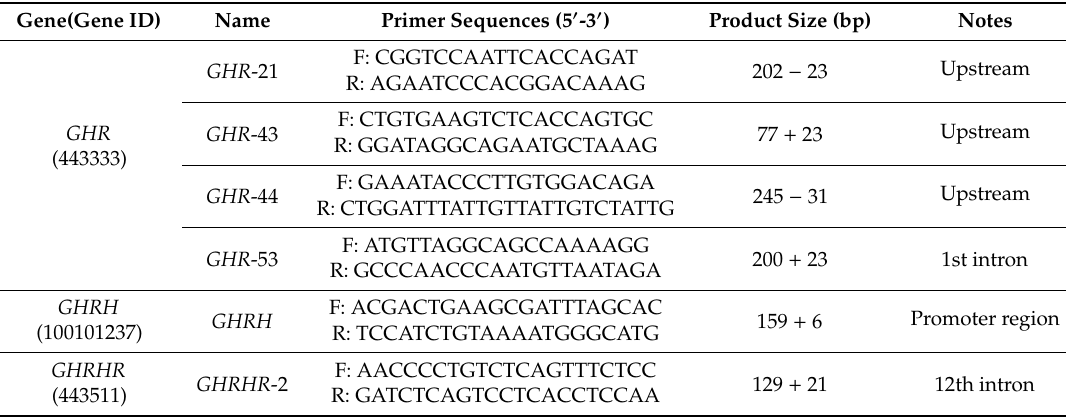
Table 2. PCR primer sequences of sheep GHR , GHRH , and